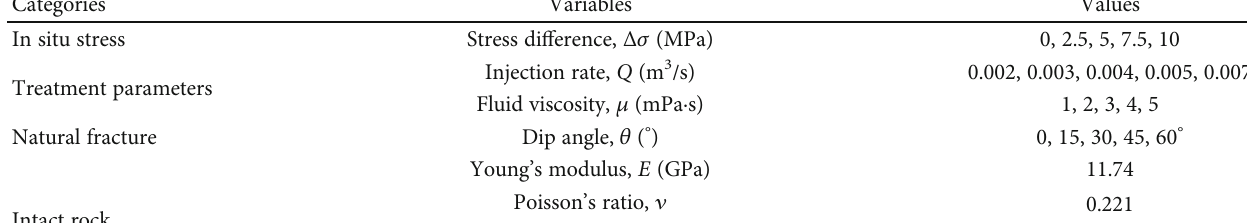
Table 1: Mechanical and hydraulic model input parameters.